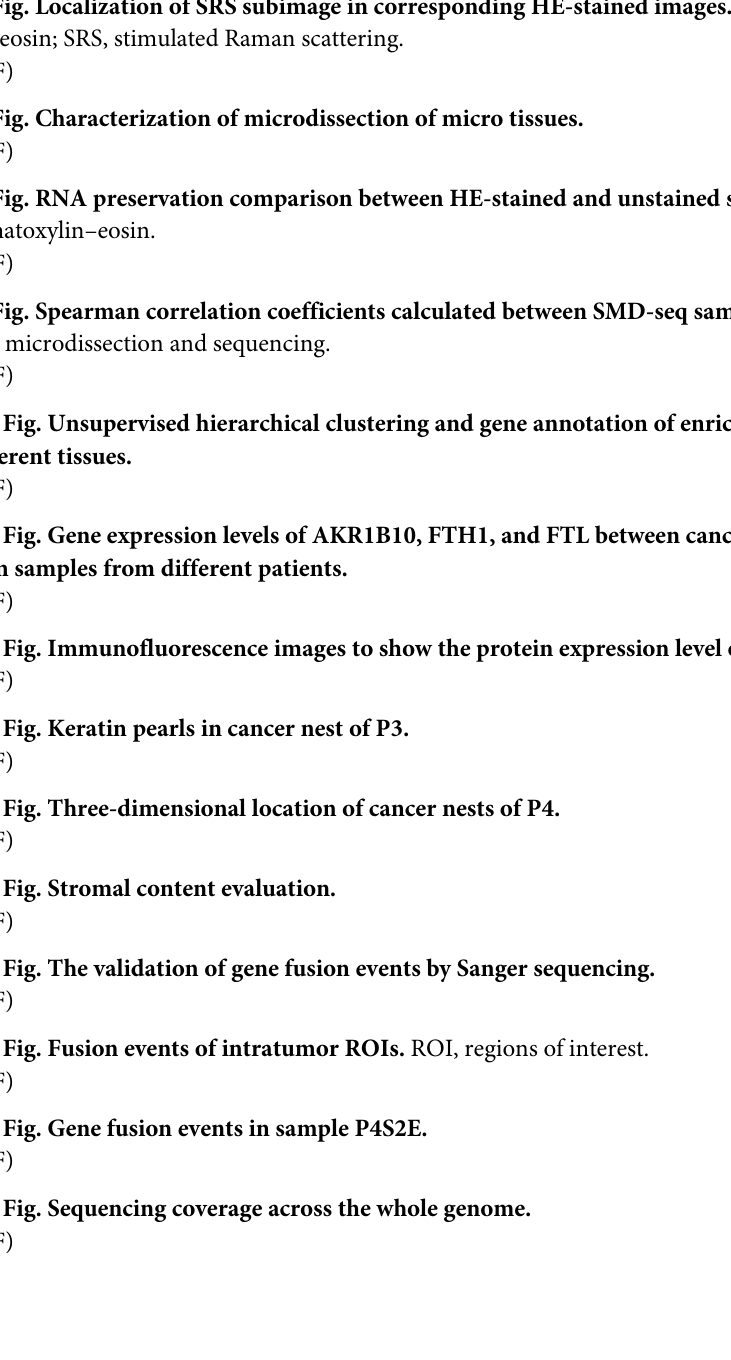
S3 Fig. SRS images of epithelium and cancer for unsupervised hierarchical clustering. SRS, stimulated Raman scattering. (TIF) S4 Fig. Correlation matrix of samples in 16 cancer samples and 16 epithelium samples. (TIF) S5 Fig. Images of cancer infiltrating muscle of P4. (TIF) S6 Fig. Localization of SRS subimage in corresponding HE-stained images. HE, hematoxy- lin–eosin; SRS, stimulated Raman scattering. (TIF) S7 Fig. Characterization of microdissection of micro tissues. (TIF) S8 Fig. RNA preservation comparison between HE-stained and unstained sections. HE, hematoxylin–eosin. (TIF) S9 Fig. Spearman correlation coefficients calculated between SMD-seq samples. SMD-seq, SRS microdissection and sequencing. (TIF) S10 Fig. Unsupervised hierarchical clustering and gene annotation of enriched genes in different tissues. (TIF) S11 Fig. Gene expression levels of AKR1B10, FTH1, and FTL between cancer and epithe- lium samples from different patients. (TIF) S12 Fig. Immunofluorescence images to show the protein expression level of GSTP1. (TIF) S13 Fig. Keratin pearls in cancer nest of P3. (TIF) S14 Fig. Three-dimensional location of cancer nests of P4. (TIF) S15 Fig. Stromal content evaluation. (TIF) S16 Fig. The validation of gene fusion events by Sanger sequencing. (TIF) S17 Fig. Fusion events of intratumor ROIs. ROI, regions of interest. (TIF) S18 Fig. Gene fusion events in sample P4S2E. (TIF) S19 Fig. Sequencing coverage across the whole genome.